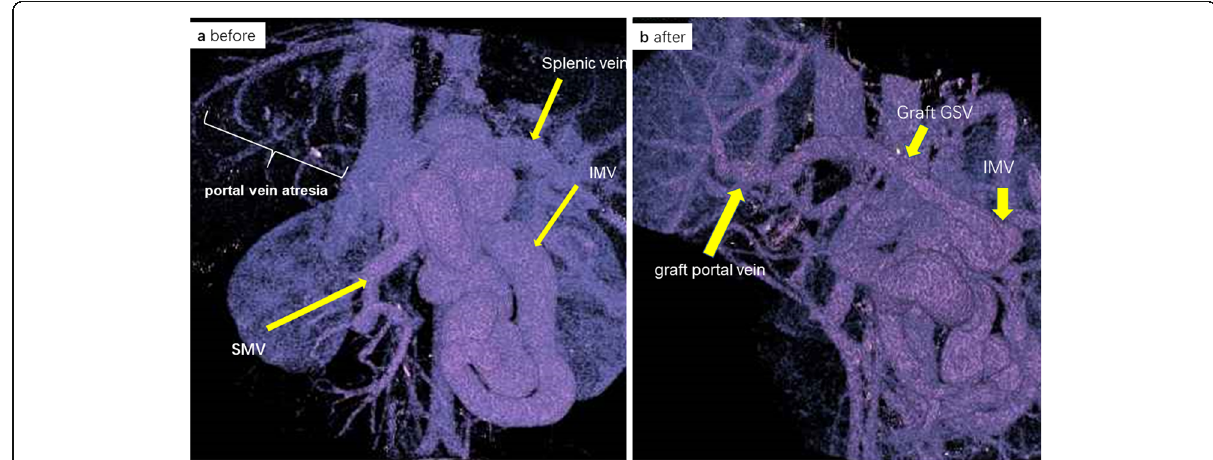
Fig. 1 Three-dimensional reconstruction images of the PV system before and after LDLT. a Preoperative image showed PV atresia with an enlarged IMV from splenic vein to IVC. b Postoperative image showed the patency of the PV and the venous graft GSV at 2 to 3 months after